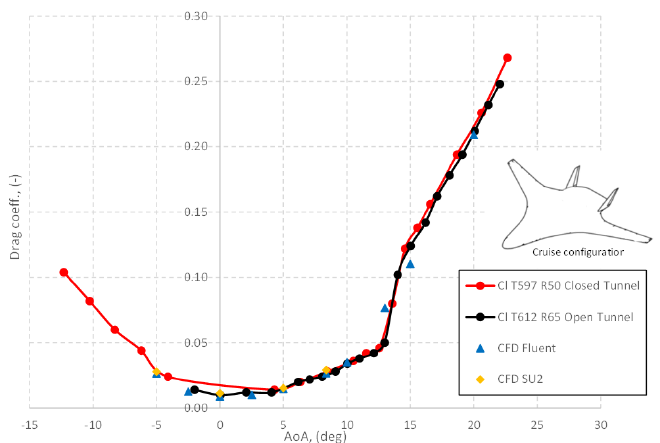
Figure 13. Drag coefficient. Comparison between present results and literature data